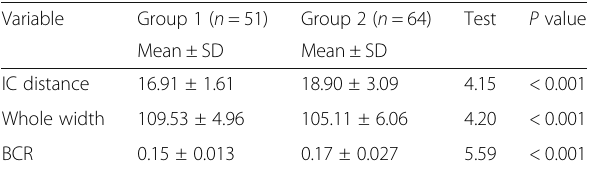
Table 3 The mean BCR (+ SD) among MS and ischemic leukoencephalopathy